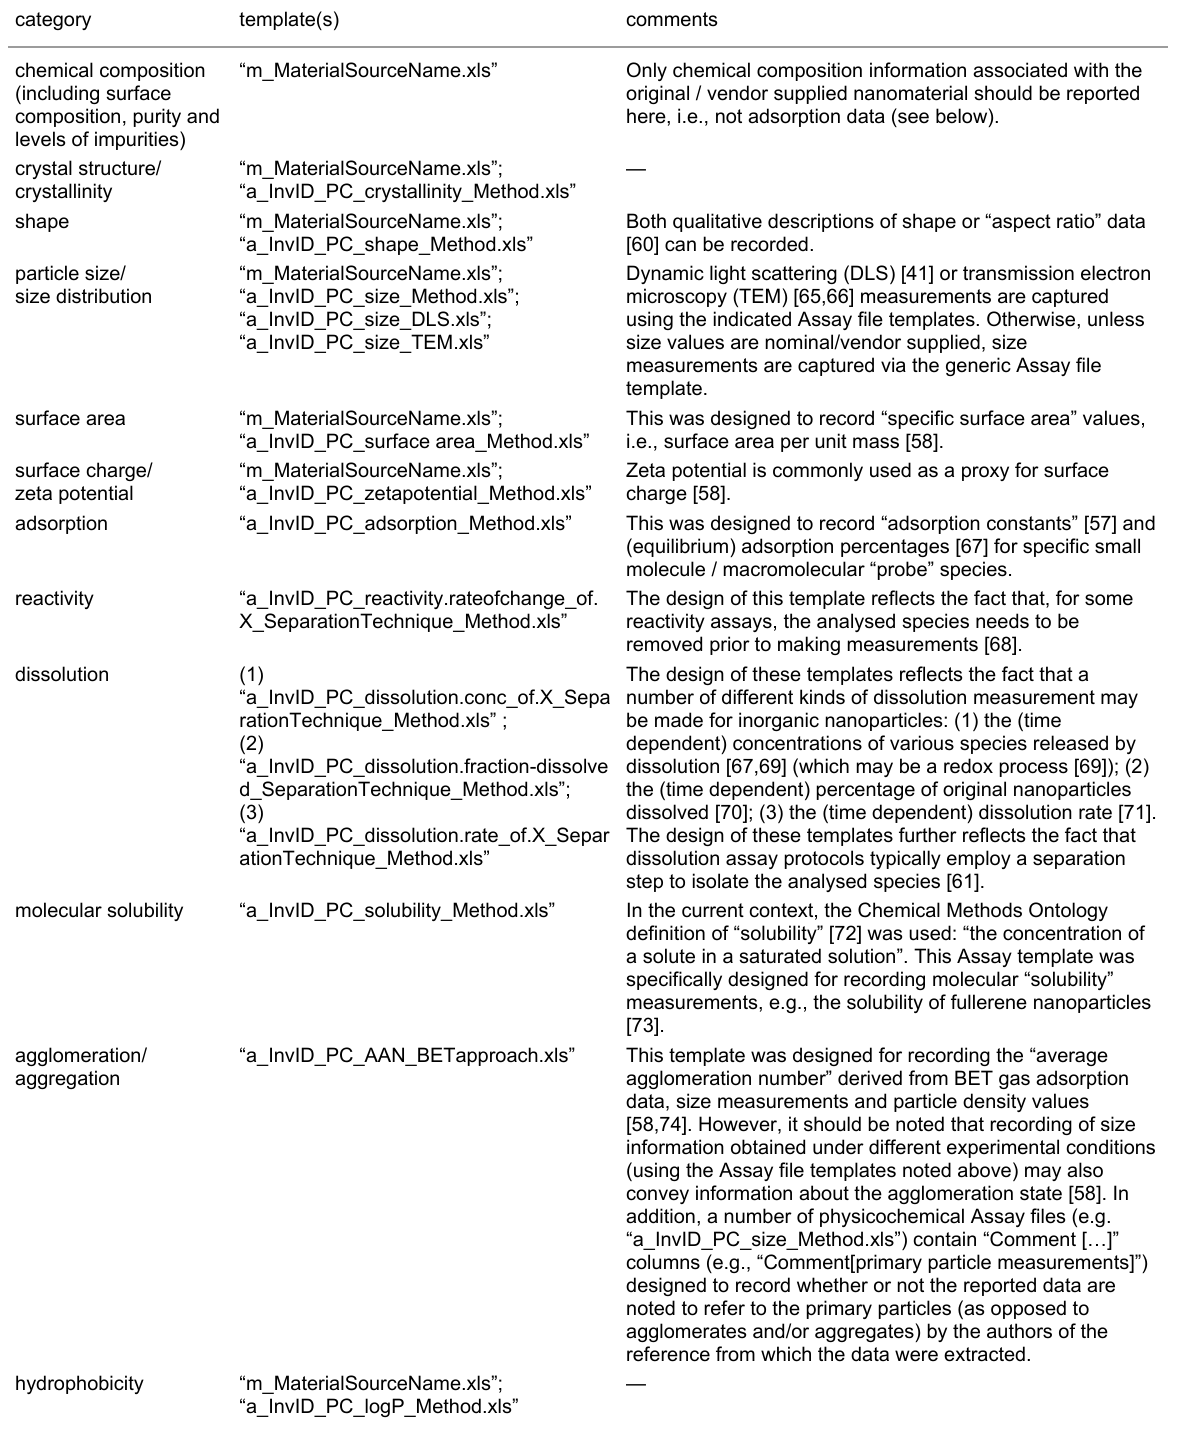
Table 2: Categories of physicochemical information which the NanoPUZZLES ISA-TAB-Nano templates were designed to